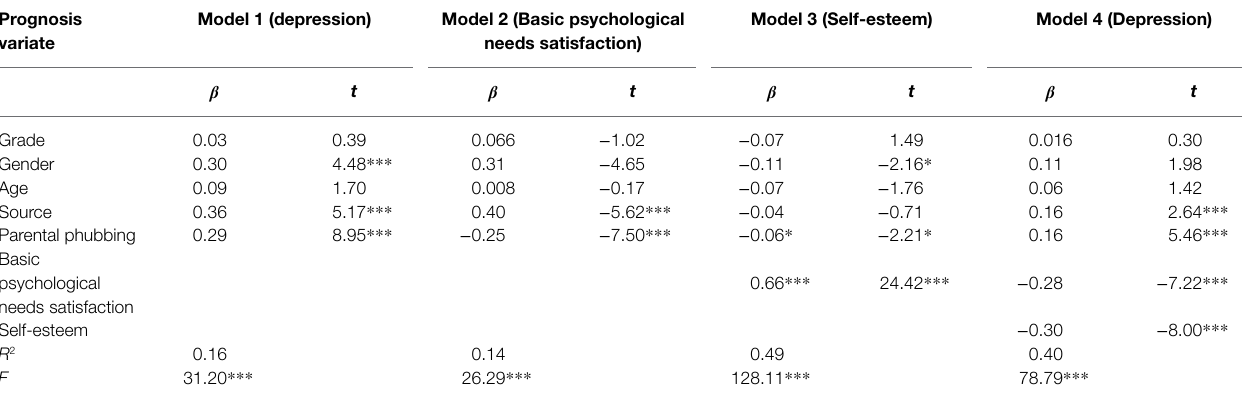
TABLE 2 | Chain mediating analysis of parental phubbing and depression in junior middle school students. Prognosis Model 1 variate